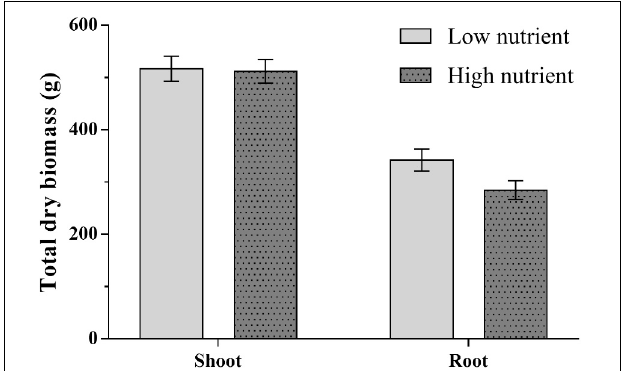
FIGURE 2 | Mean total dry above and below ground biomass for apple trees ( Malus pumila ) grown under high and low nutrient treatments. Error bars represent ± SE per treatment ( n = 24). Below ground biomass was significantly affected by nutrient treatment ( P < 0.01), scion type ( P < 0.01), and rootstock type ( P < 0.001). Above ground biomass was significantly affected by rootstock type ( P < 0.05)